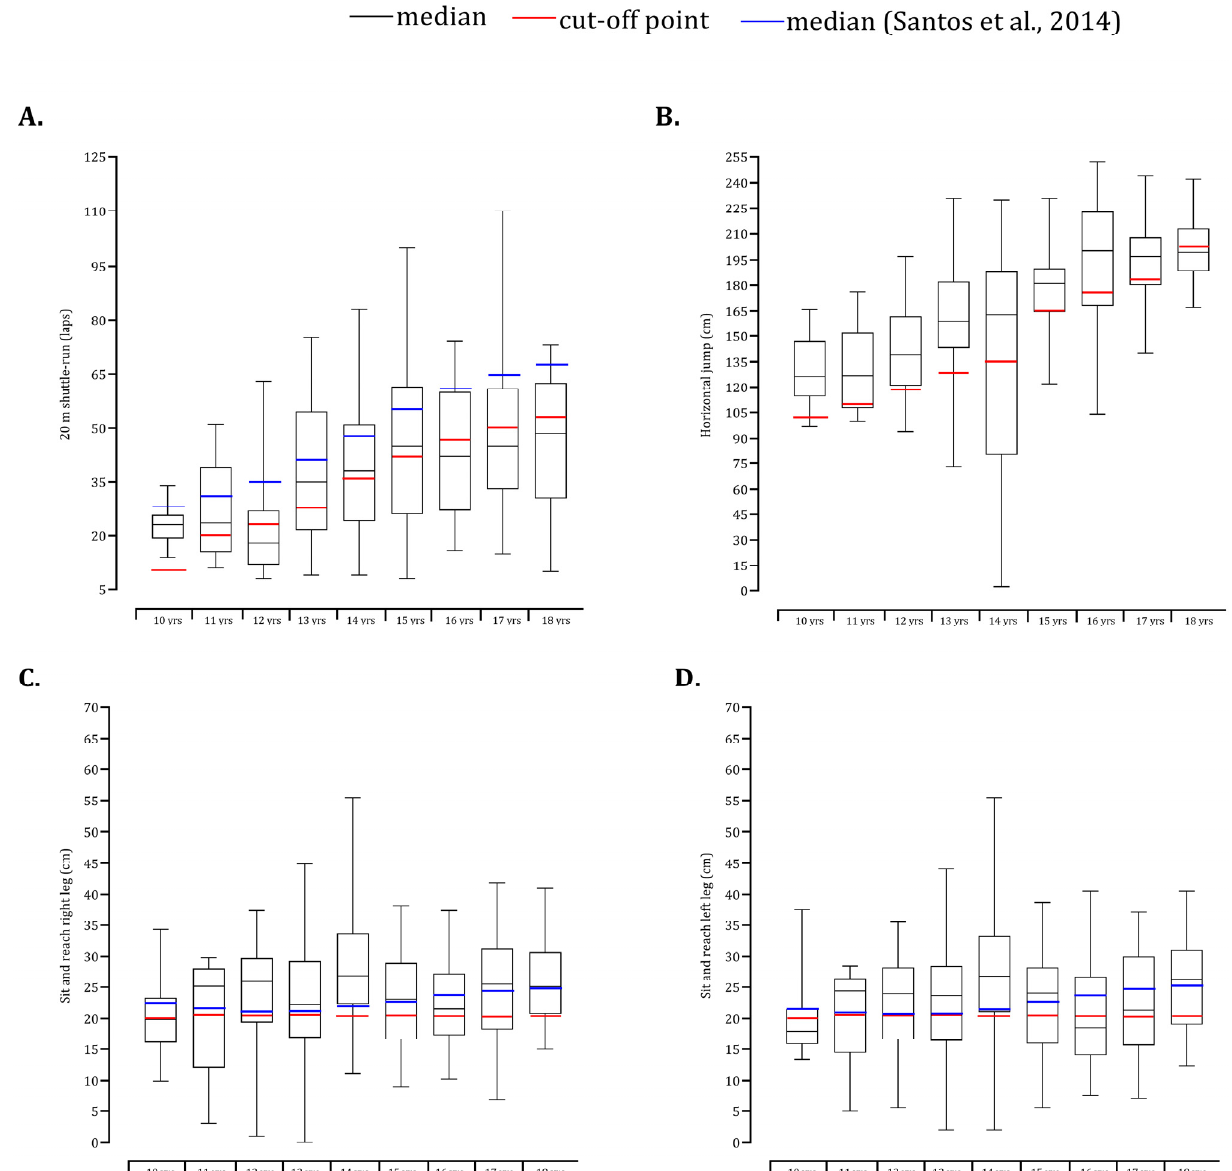
Figure 4. Box and whisker plots of school male participants plotted relative to cut-off standards for fitness battery (20 m shuttle-run: ( A ); horizontal jump: ( B ); sit and reach right leg: ( C ); sit and reach left leg: ( D )) [14].